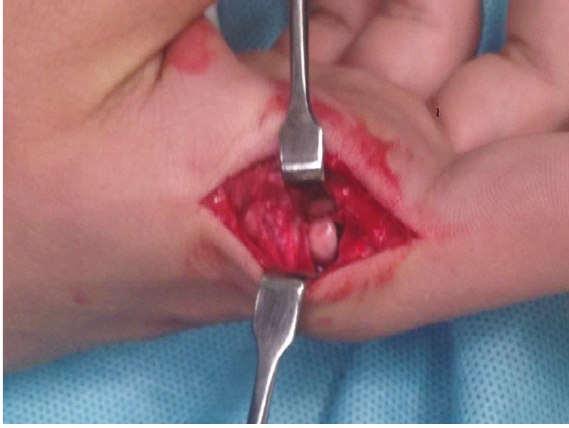
Figure 4: Lateral approach on the MCP joint.